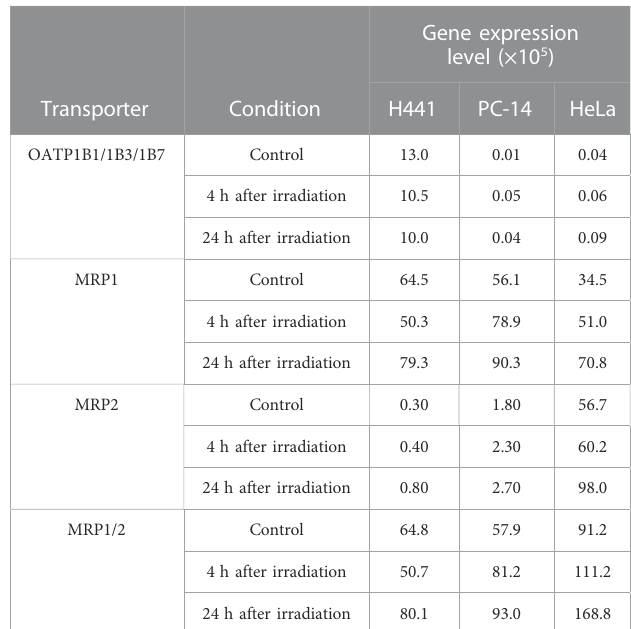
TABLE 2 Gene expression levels of measured drug transporter in each cell by conducting Real-time